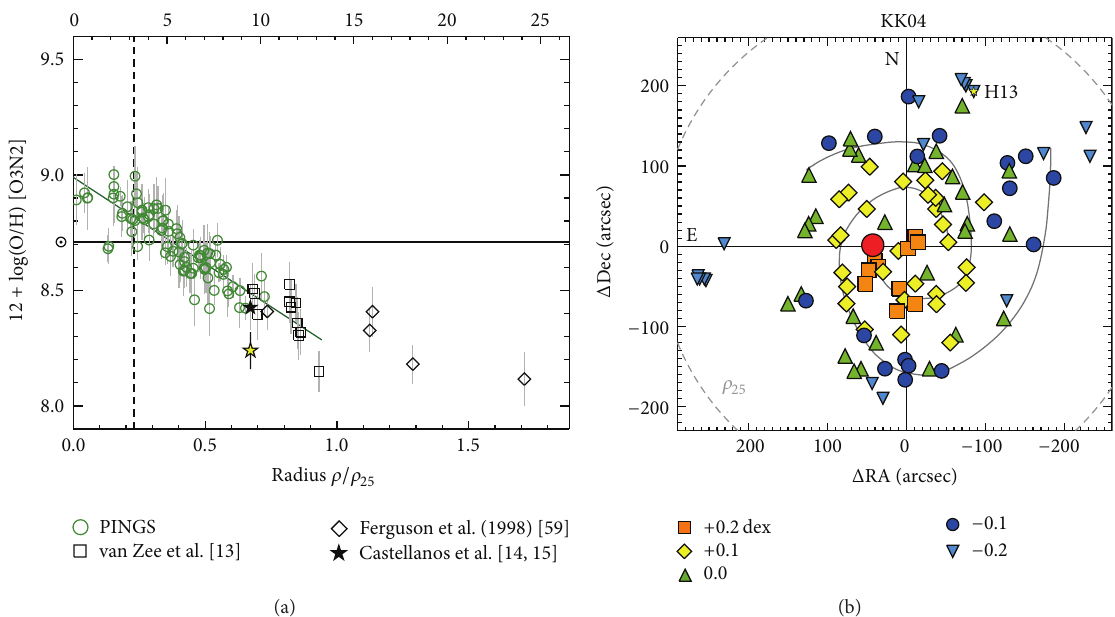
Figure 3: (a) Radial abundance gradient derived for NGC 628 based on the PINGS HII region catalogue (green symbols), and HII regions from the literature (black symbols) using the O3N2 calibrator. The horizontal grey lines correspond to the abundance derived using the integrated spectrum as reported in Paper I. The top 𝑋 -axis values correspond to the projected radii in arcsec for the radial average data. Note the flattening of the gradient for innermost regions of the galaxy and for radii > 𝜌 25 , that is, a multimodality of the abundance gradient. (b) 2D distribution of the oxygen abundance derived from the IFS H II regions catalogue of NGC 628 (plus selected HII regions from the literature), for the KK04 (top-left) metallicity calibrators. The shape and colours of the symbols correspond to the difference Δ [12 + log(O/H)] ≡ Δ log (O/H) between the abundance obtained on each HII region with respect to the characteristic abundance 12 + log(O/H) 𝜌=0.4𝜌 calibrator, grouped into bins of 0.0, ± 0.1, 0.2 dex (e.g., +0.1dex = 0.05 ≤ Δ log (O/H) < 0.15). The large symbol in red colour stands for the location of the HII region with the maximum amount of 12 + log(O/H) measured for that calibrator. The grey thick lines define the operational spiral arms of the galaxy. The dotted circle corresponds to the size of the optical radius 𝜌 25 . Figure adapted from Rosales-Ortega et al.